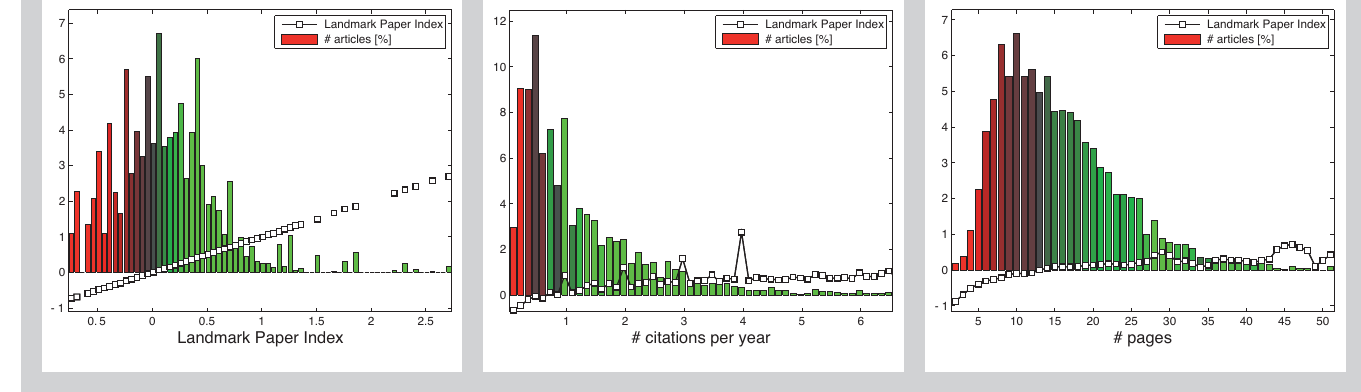
Figure 1 (left): Number of all articles - pub- lished by h -journals in the time frame 1991 - 2006 - versus Landmark Paper Index (LPI). For the online edition, the bars are color- coded by the LPI (squares). Figure 2 (middle): Total number of citations divided by number of years after the year of publication versus LPI. Figure 3: Number of article pages and their correlation with the